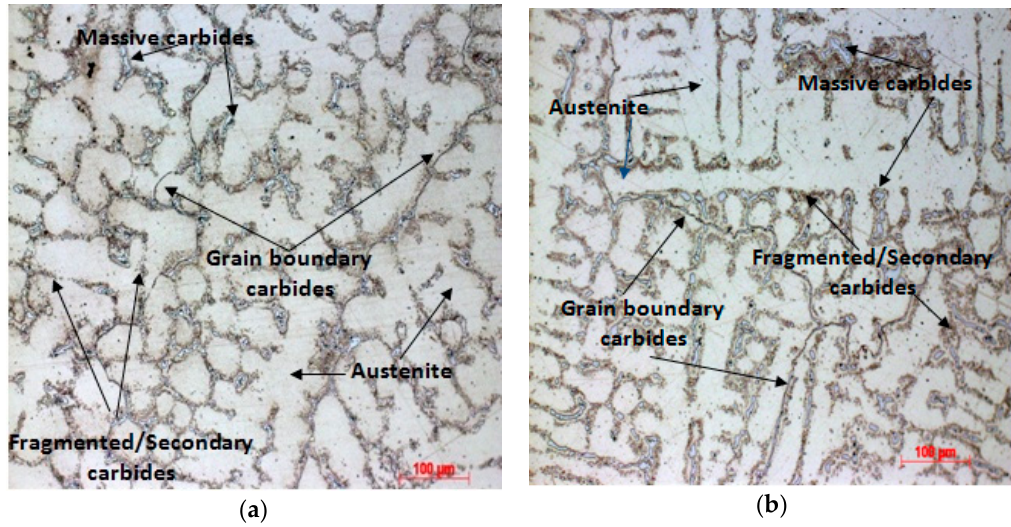
Figure 5. ( a ) Microstructure obtained after solution annealing at 1200 °C for 1.5 h followed by oven cooling; ( b ) Sample solution annealed at 1200 °C for 3 h followed by oven cooling.